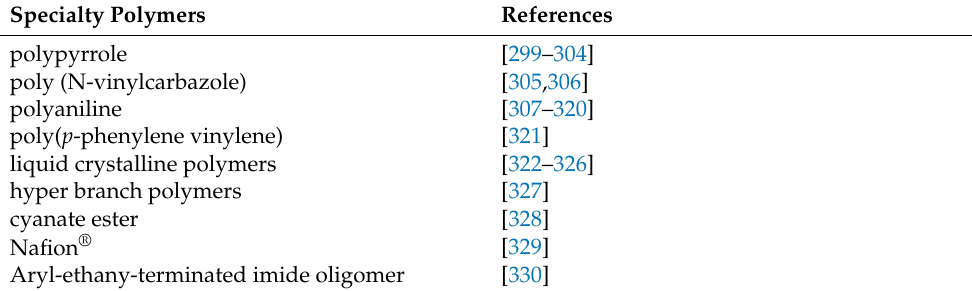
Table 5. Specialty